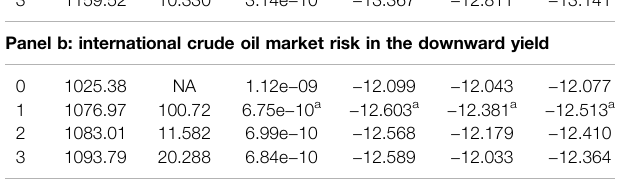
Panel b: international crude oil market risk in the downward yield